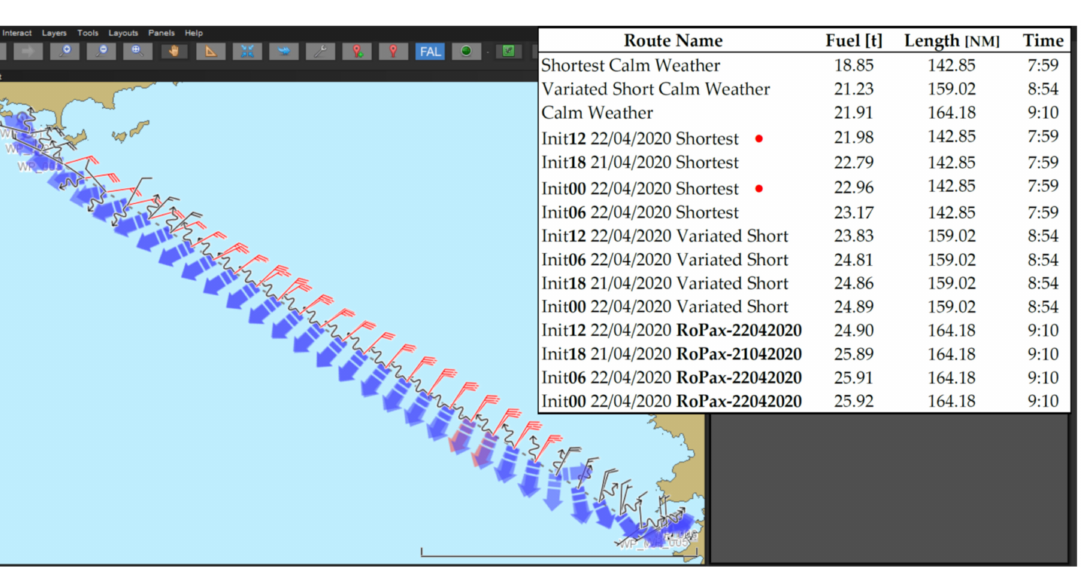
Figure 10. In the map to the left: visualization, through the prototype interface, of metocean data along the shortest route. The data from the forecast runs initialized on 22/04/2020 at 00 and at 12 UTC are superimposed to graphically check their concordance. The “Routes sorting” table on the top right, shows the fuel consumption estimates, for each one of the four routes of Figures 8 and 9, as estimated by alternatively using data from four consecutive models runs and in calm weather. The Time column shows voyage duration in hours and minutes